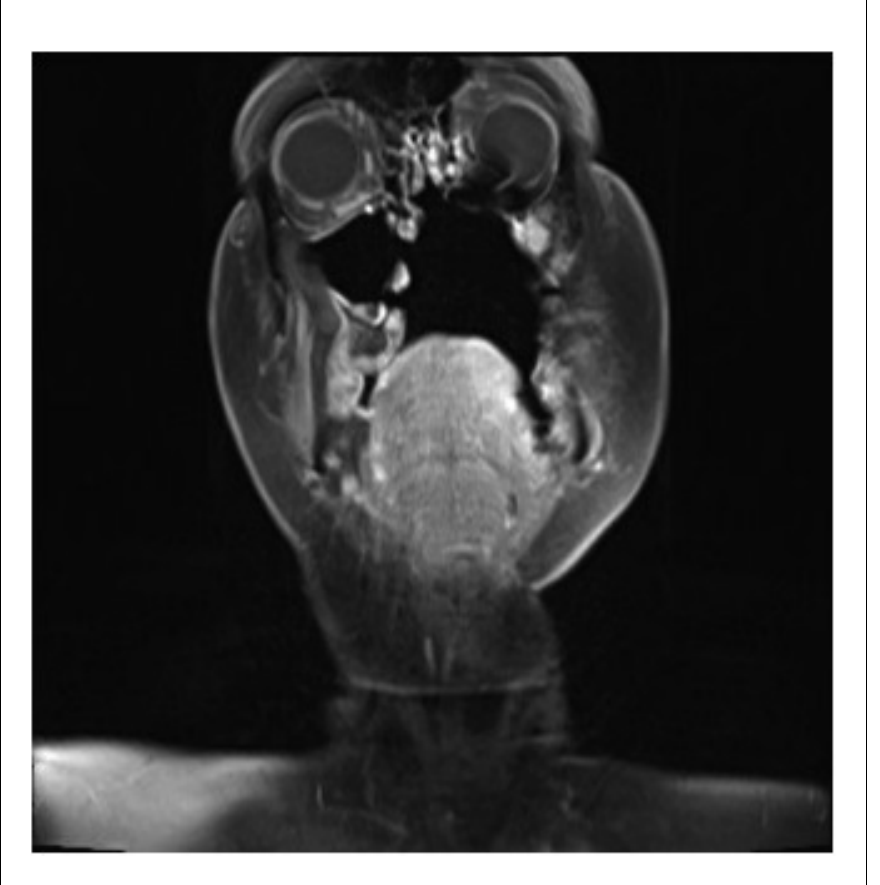
Figure 2. Coronal CT imaging following radical surgery to remove